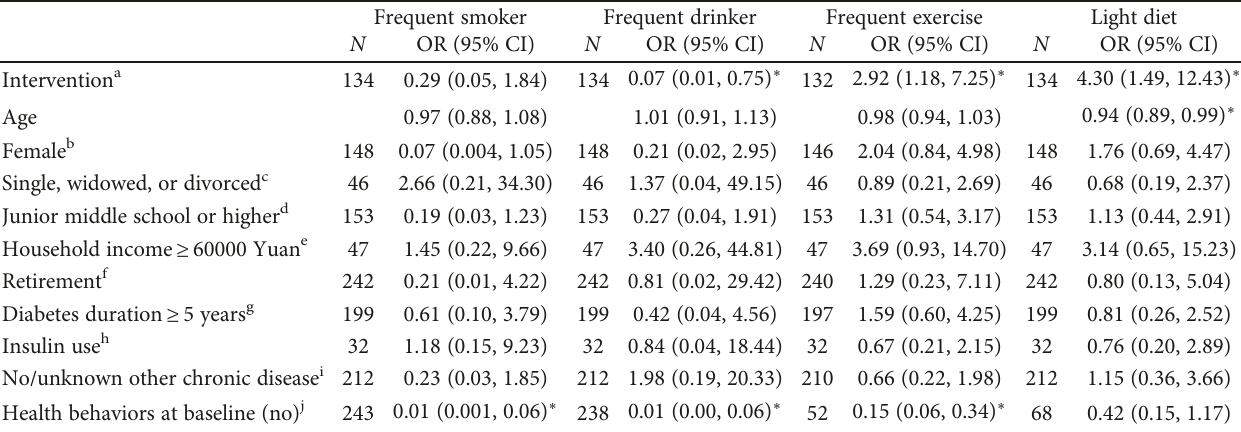
Table 2: Binary logistic regression analyses of health behavior outcomes in a 9-month group randomized experimental study in China,